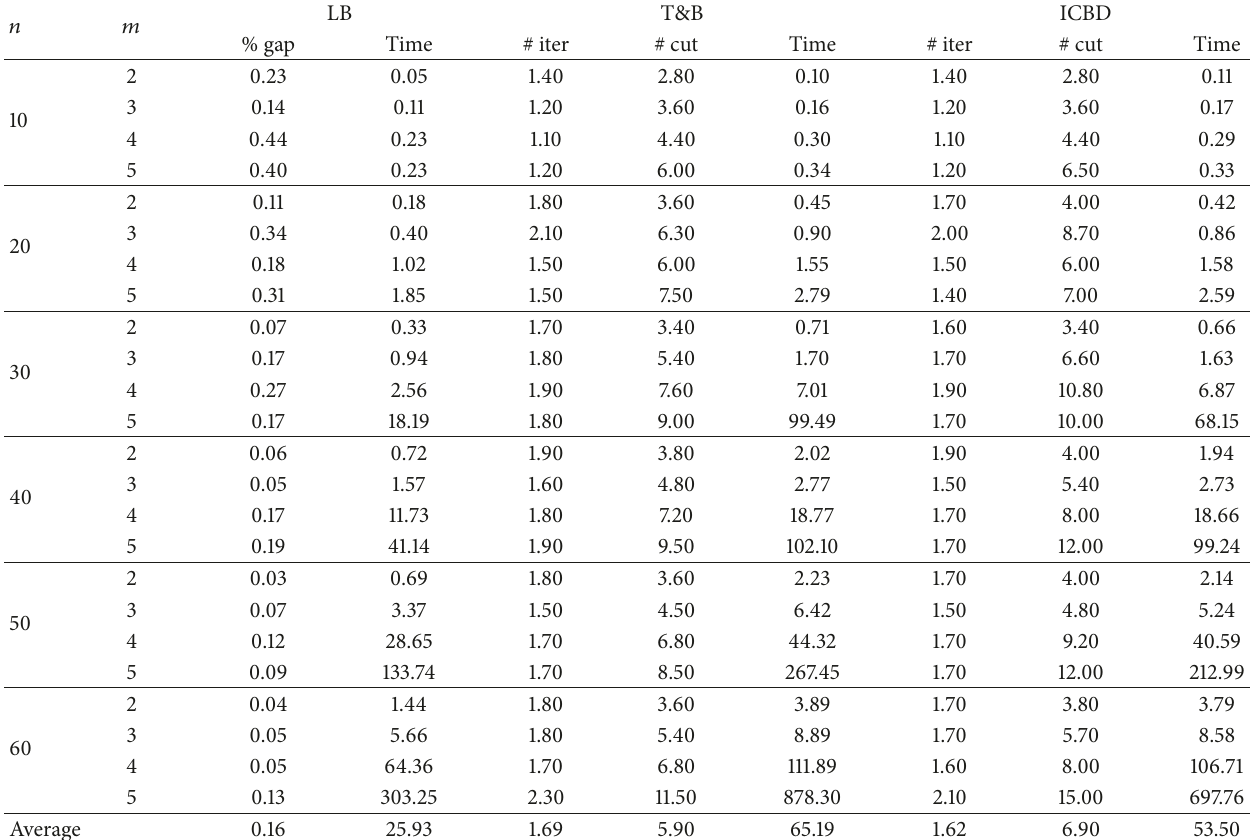
Algorithm 2: ICBD. ∗ Restricted or original master problem. Table 1: Comparison of T&B and ICBD methods using the instances from Tran and Beck